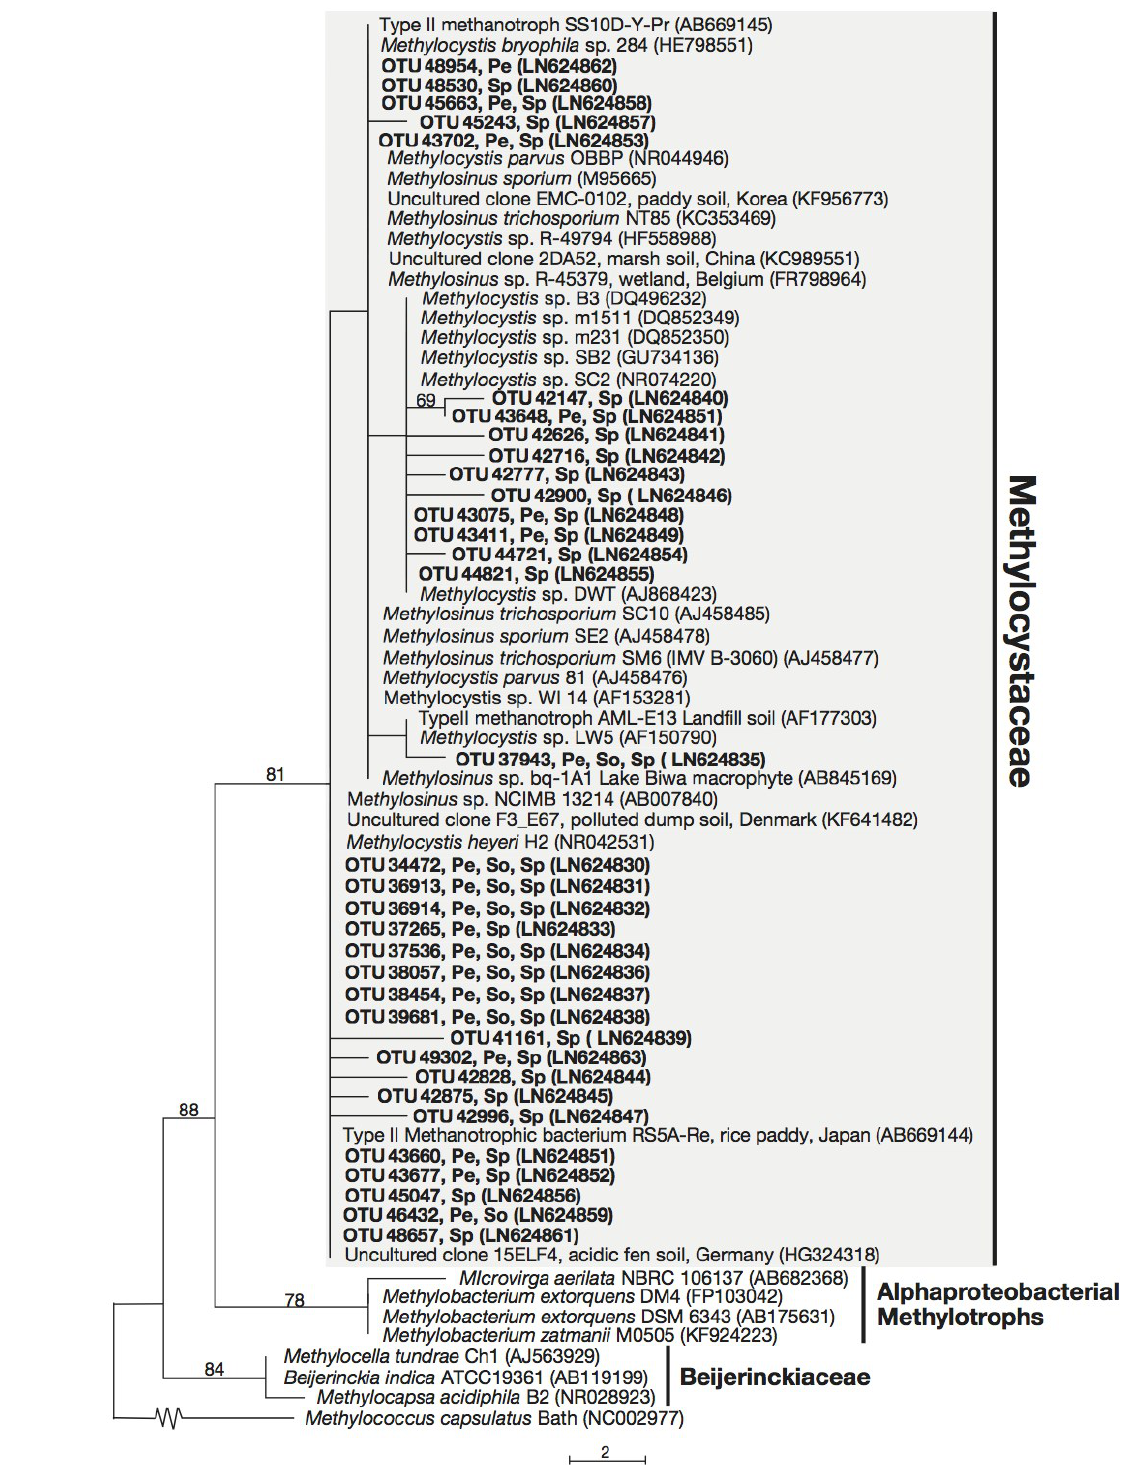
Figure 2. Phylogenetic tree based on maximum parsimony (MP) analysis of thirty-four OTUs (~169 bp) detected in this study (in bold) in comparison with their close relatives and representatives from the Methylocystaceae. The locations where these OTUs were detected are indicated: Pe, peat; So, forest soil; Sp, Sphagnum moss. Bootstrap values from 1000 replicates are indicated at the nodes of branches (if > 50). The scale bar represents the number of nucleotide